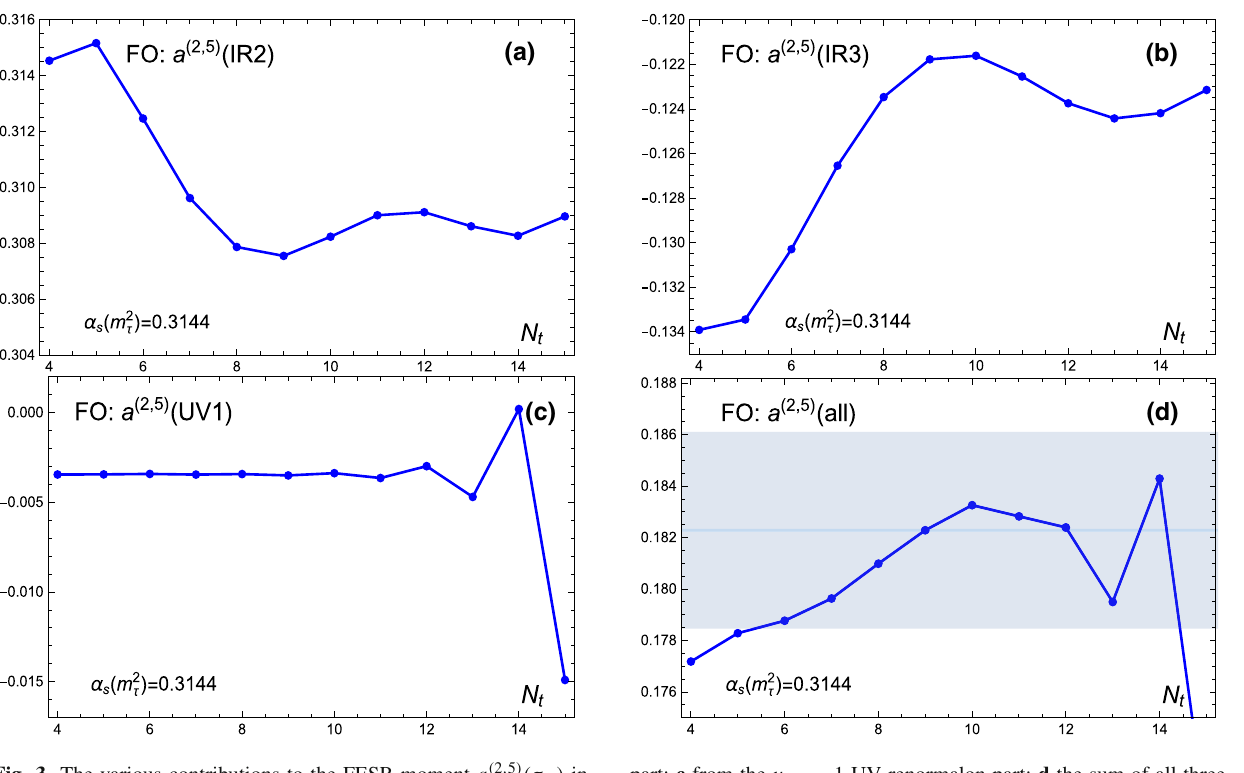
part; c from the u = − 1 UV renormalon part; d the sum of all three contributions, i.e., the full theoretical FOPT value of a ( 2 , 5 ) (σ m ) ; the blue vertical lines in d represent the band of the experimental